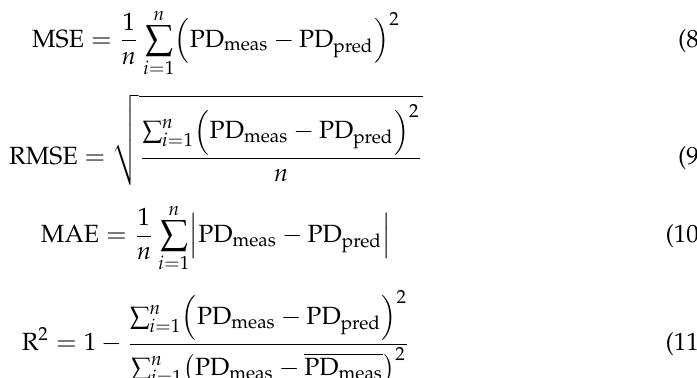
Table 6. The effect of two different activation functions on the predictive performance of the ANN- based